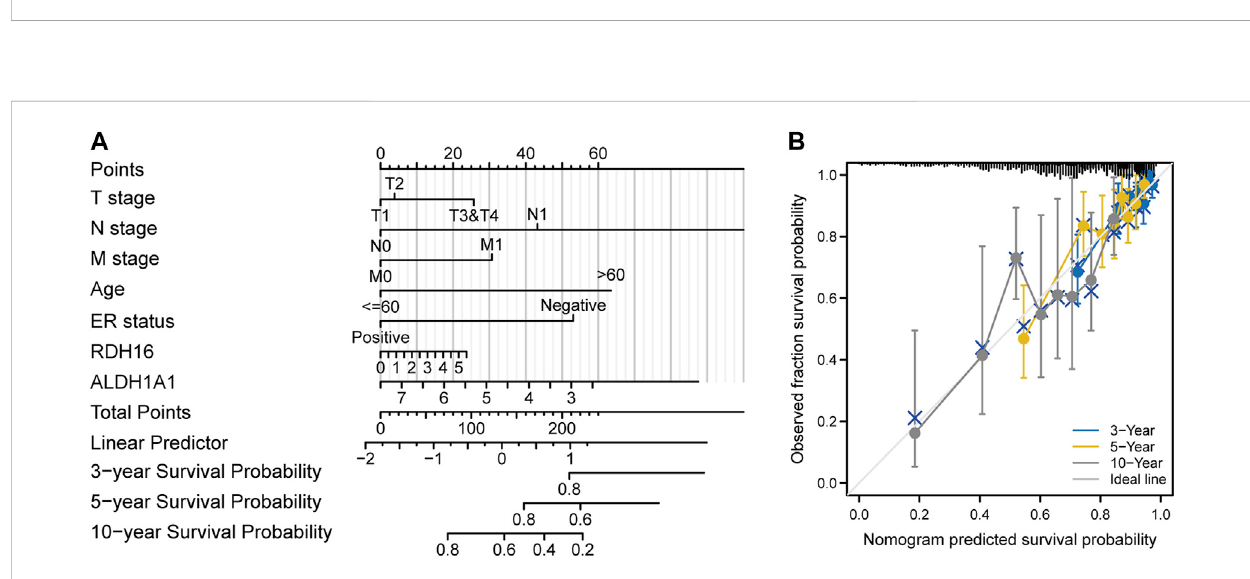
FIGURE 9 Construction of a prognostic model. (A) Column line graph. (B) Calibration